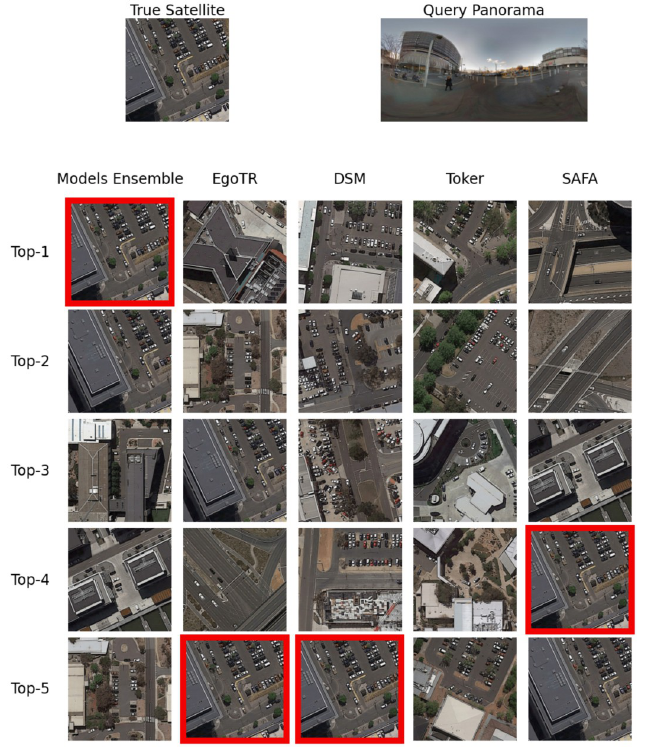
Fig 11. An example that shows the ensemble model r@(1—5) compared to the individual models on the CVACT dataset. The true satellite has a red border.